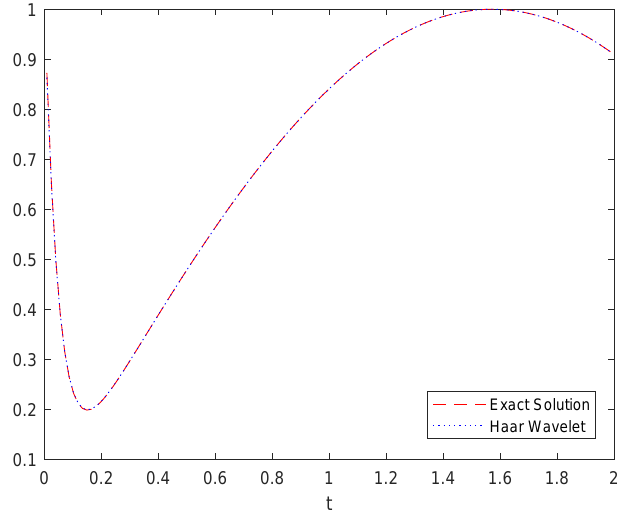
Figure 1. Exact solution and the approximate solutions calculated for J = 6 and i = 128 by Haar Wavelet for Eqn.